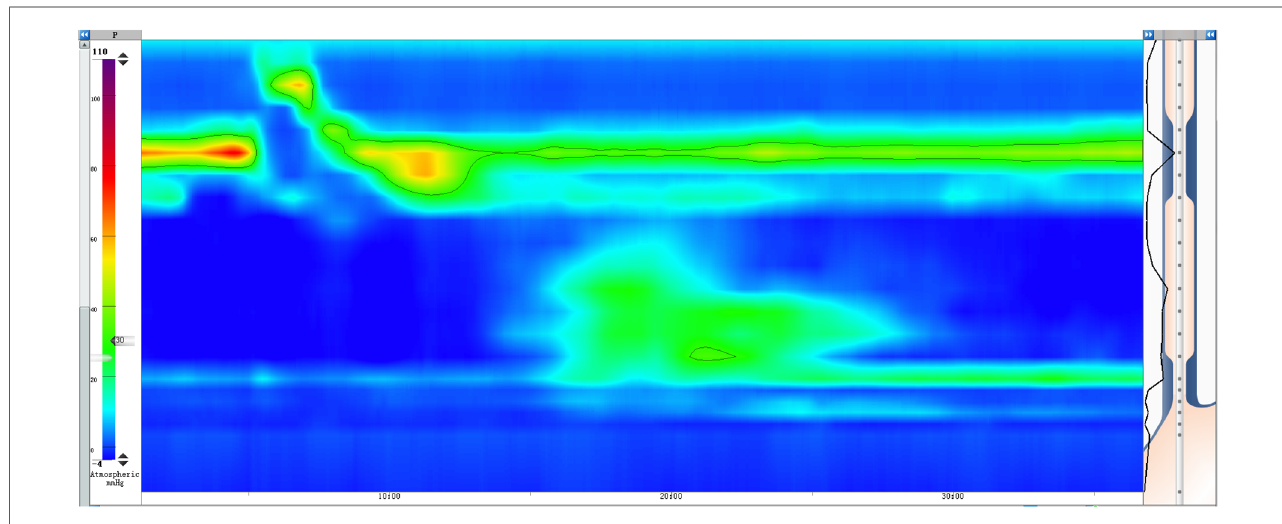
FIGURE 3 HREM showed a mean IRP of 9.0 mmHg, DCI of 125 mmHg · s · cm, DL of 4.2 s, and a CFV of more than 100 cm/s in test swallows with poor peristalsis in the esophageal body. DCI, distal contractile integral; DL, delayed latency; CFV, contractile frontal